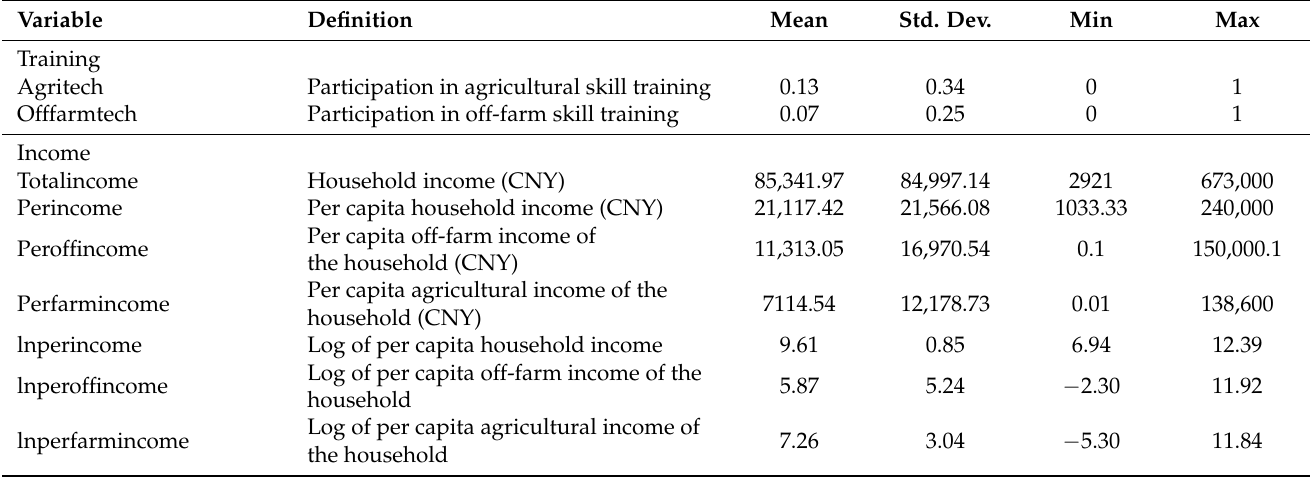
Table 2. Descriptive statistics of the